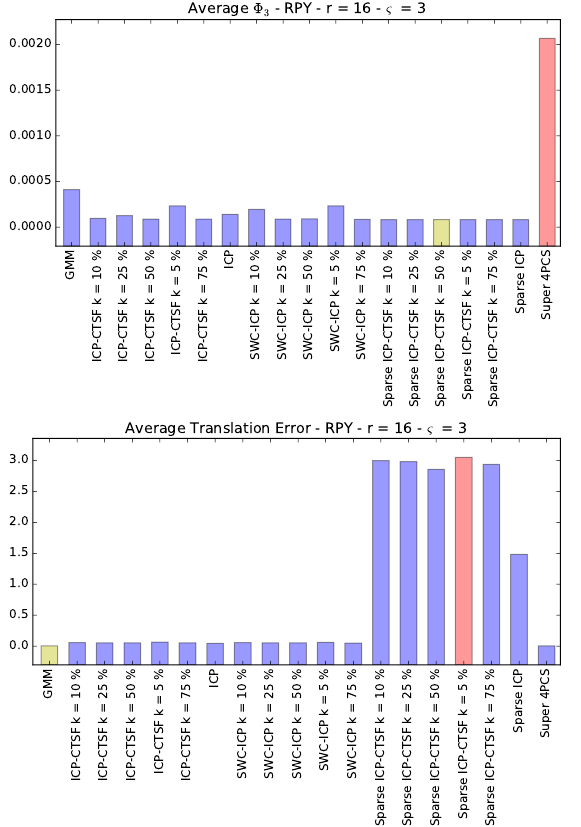
Fig. 22: Results for video ‘freiburg2 rpy’ : (a) Mean rotation error given by expression (47) . (b) Translation error computed by expression (48).